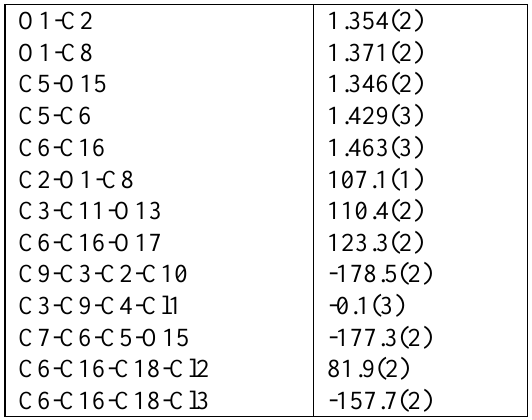
Table 1. Selected bond lengths [Å] and angles [deg] and selected torsional angles [deg] for VI